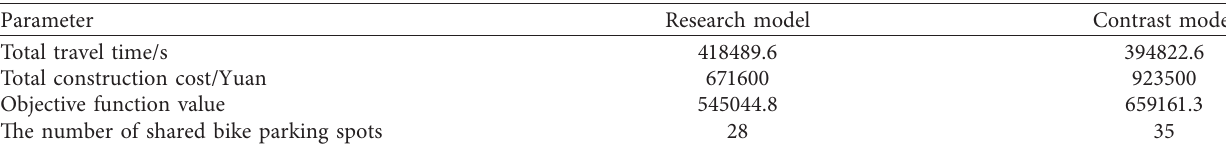
Table 4: Comparative analysis of optimization results.